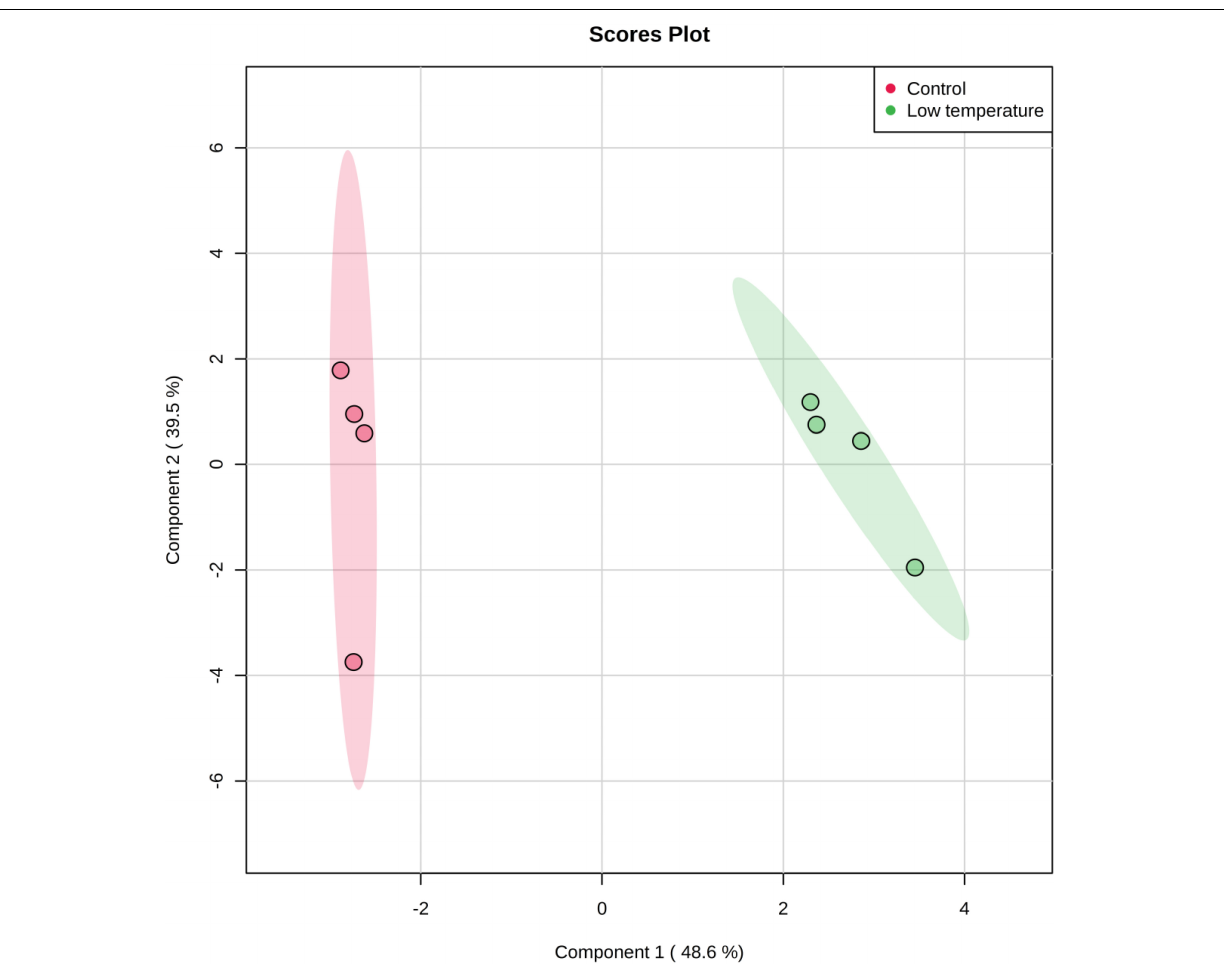
FIGURE 2 | Partial Least Square-Discriminate Analysis (PLS-DA) scores (component 1 versus component 2) plotted from S. aureus profiles of cytoplasmic metabolites. The S. aureus cultures were grown under ideal conditions at 37 ◦ C (Control, n = 4) or exposed to low temperature at 4 ◦ C for 2 weeks (low temperature, n = 4) before the extraction of metabolites for analyses by